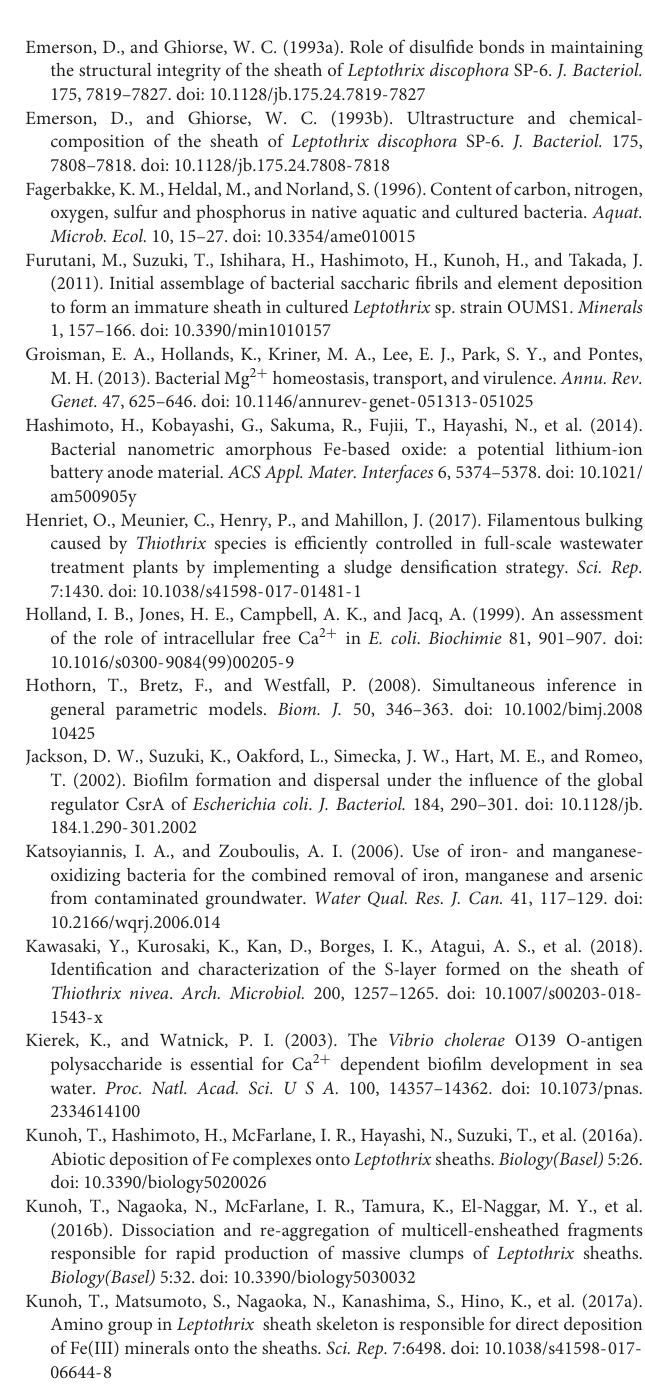
Supplementary Movie 12 | Time-lapse video of SP-6 cells cultured in MSVP-C-Ca (mp4). Supplementary Movie 13 | Time-lapse video of SP-6 cells at the bottom surface of a polymer coverslip bottom dish in MSVP (left) and MSVP-C-Ca (right) (mp4). Supplementary Movie 14 | Time-lapse video of SP-6 cells in MSVP (left) and MSVP-C-Ca (right) at the air-liquid interface of a glass bottom dish